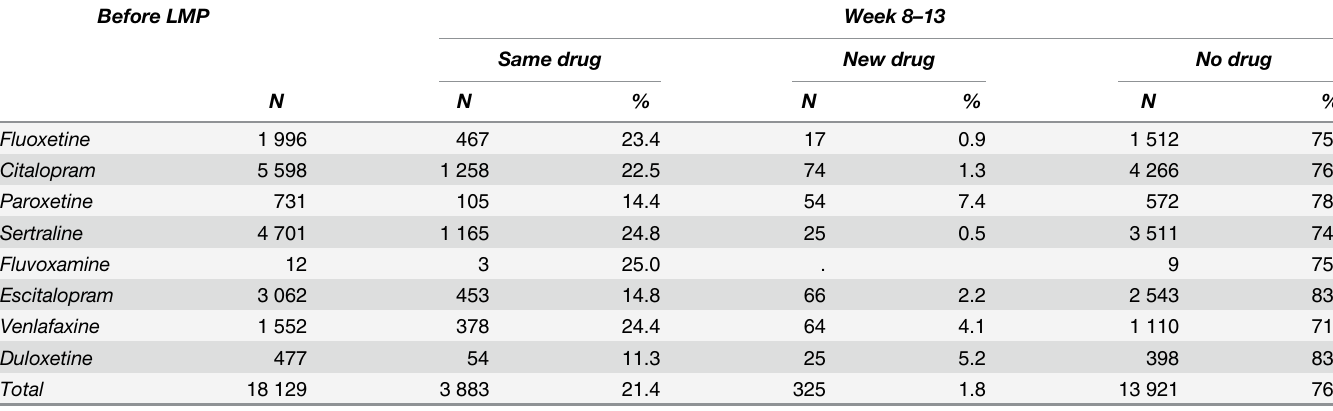
Table 2. Last SSRI/SNRI dispensing before LMP * and first dispensing in early pregnancy (weeks 8 –